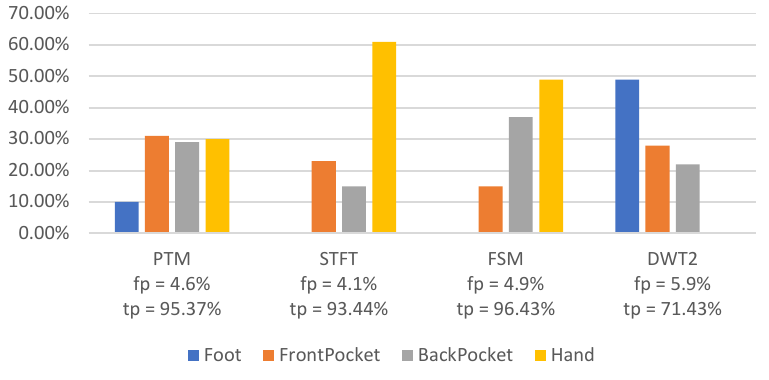
Figure 10. Error sources distribution (fp ≈ 0.05).